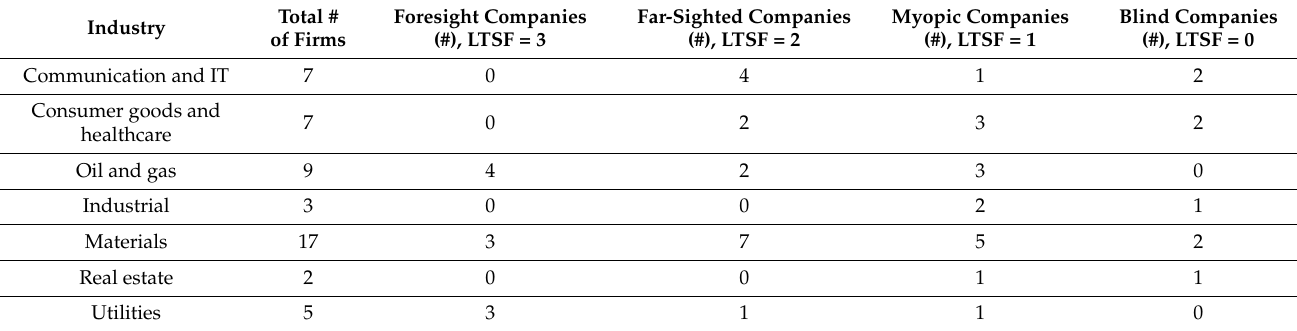
Table 5. Long-term focused companies across